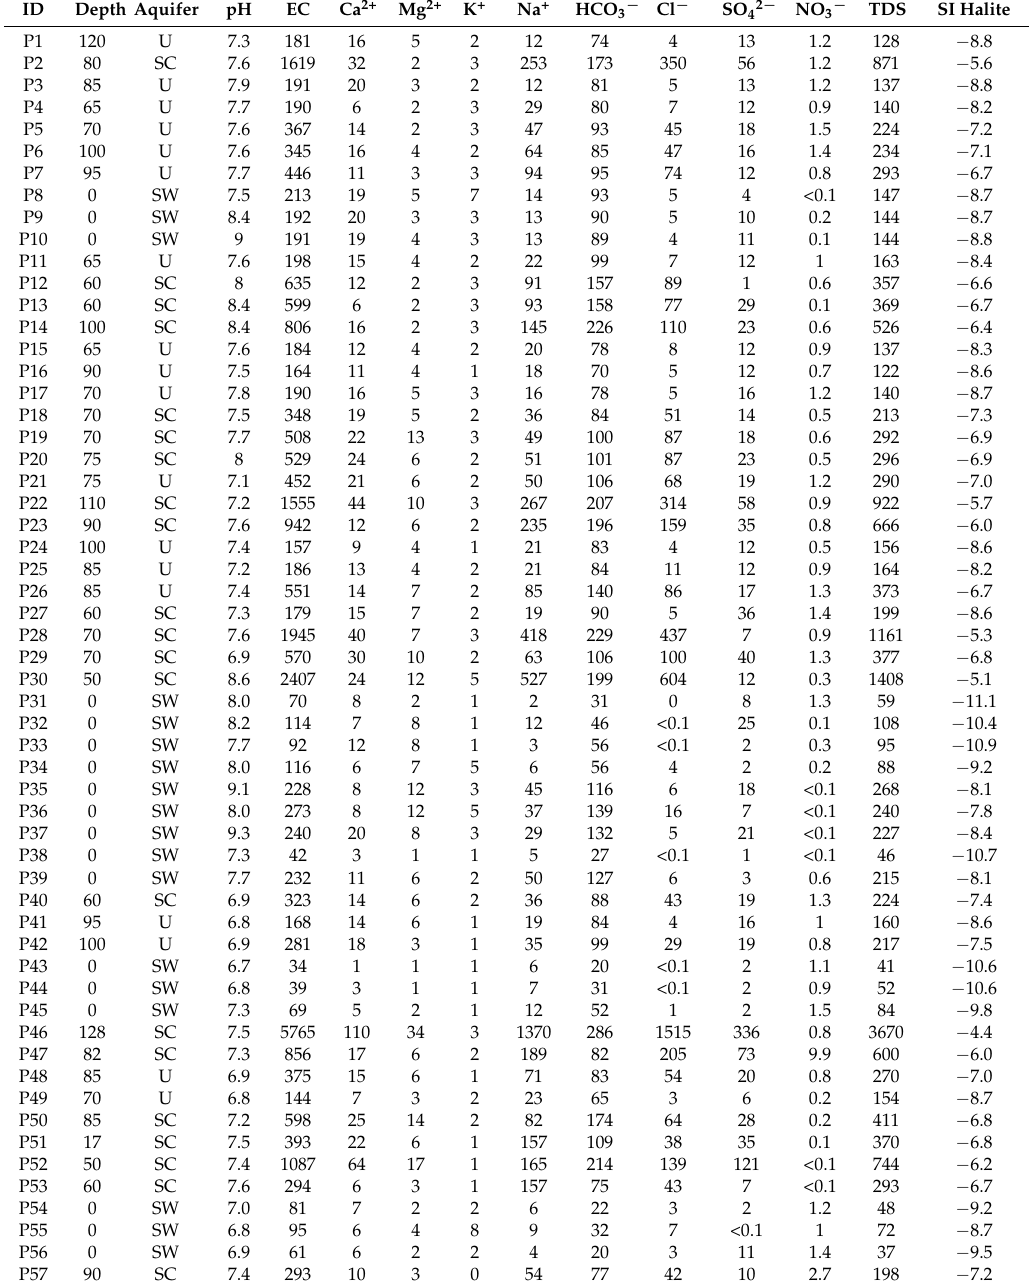
Table 2. Physicochemical components of groundwater and surface water in the study area. All the units are in mg/L, with exception of EC in µ S/cm, pH dimensionless, and depth in meters. In the column aquifer U, SC, and SW stands for unconfined, semiconfined, and surface